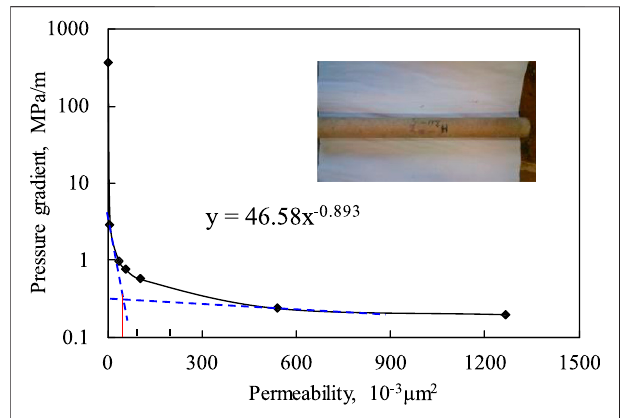
FIGURE 5 | The pressure gradient of oil restarting with different